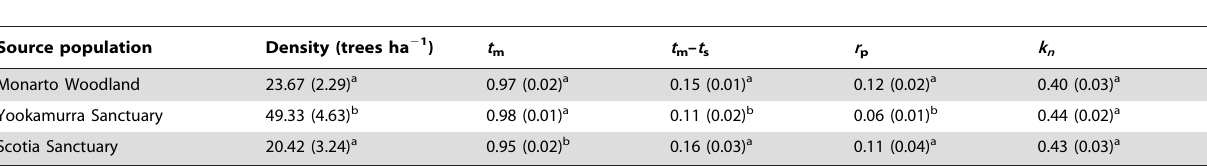
Table 2. Mating system parameter estimates for Eucalyptus gracilis from each population.